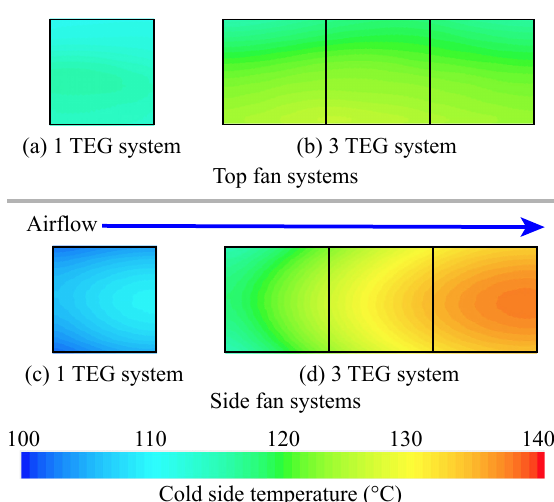
Figure 2. Cold side temperature of the TMF and SMF systems with one and three TEGs at a fan speed of 16,000 RPM; ( a ) 1 TEG system with one TMF, ( b ) 3 TEG system with three TMFs, ( c ) 1 TEG system with one SMF, and ( d ) 3 TEG system with one